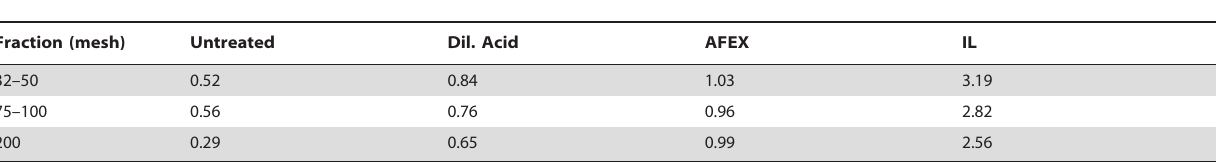
Data shown are a representation of three independent measurements (see Material and Methods).